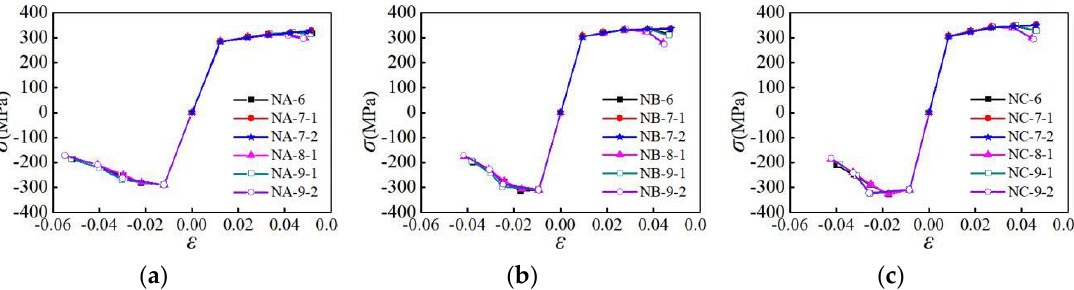
Figure 18. Influence of loading pattern on skeleton curves: ( a ) group A of specimens; ( b ) group B of